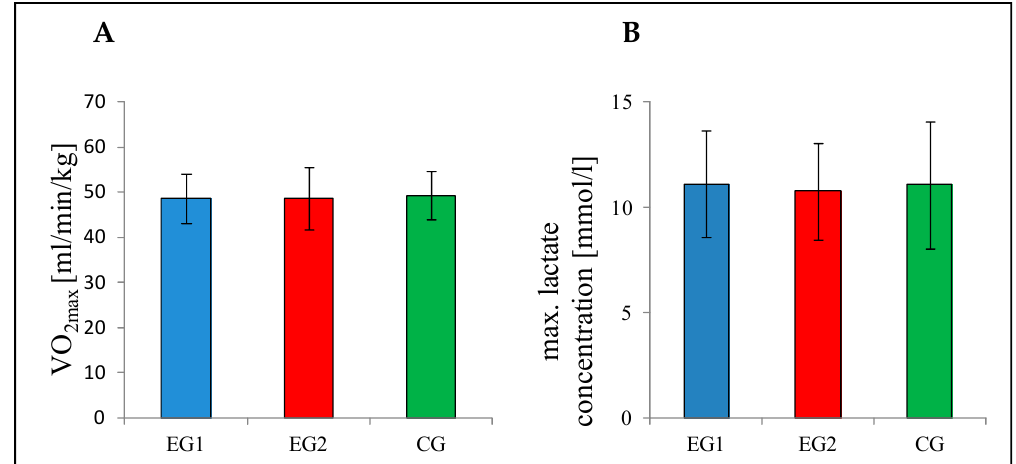
Figure 3. Parameters of the incremental step test at baseline. ( A ) Maximal oxygen uptake (VO 2max ) as a parameter for individual cardiovascular fitness and ( B ) max. lactate concentration (mmol/L) as a parameter for metabolic response. EG1 (experimental group 1, n = 13), EG2 (experimental group 2, n = 13), CG (control group, n = 13). Error bars represents the mean ± one standard deviation.